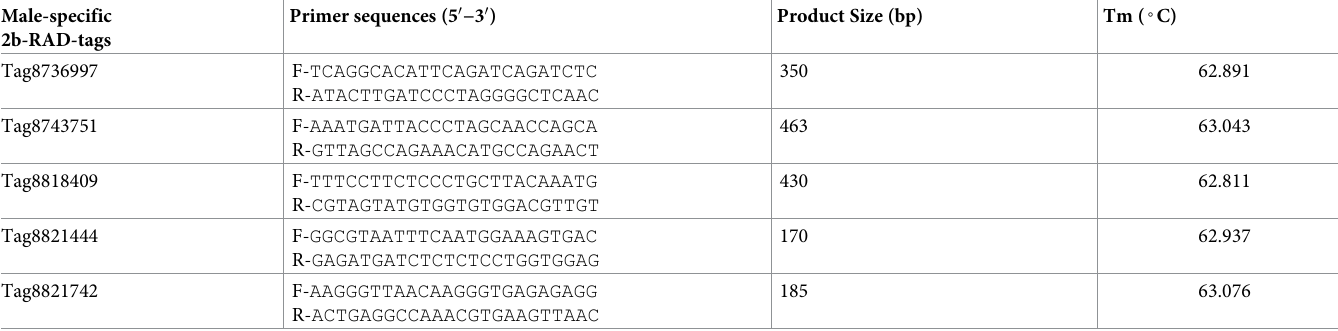
Table 5. Primers of male-specific 2b-RAD-tags. Male-specific